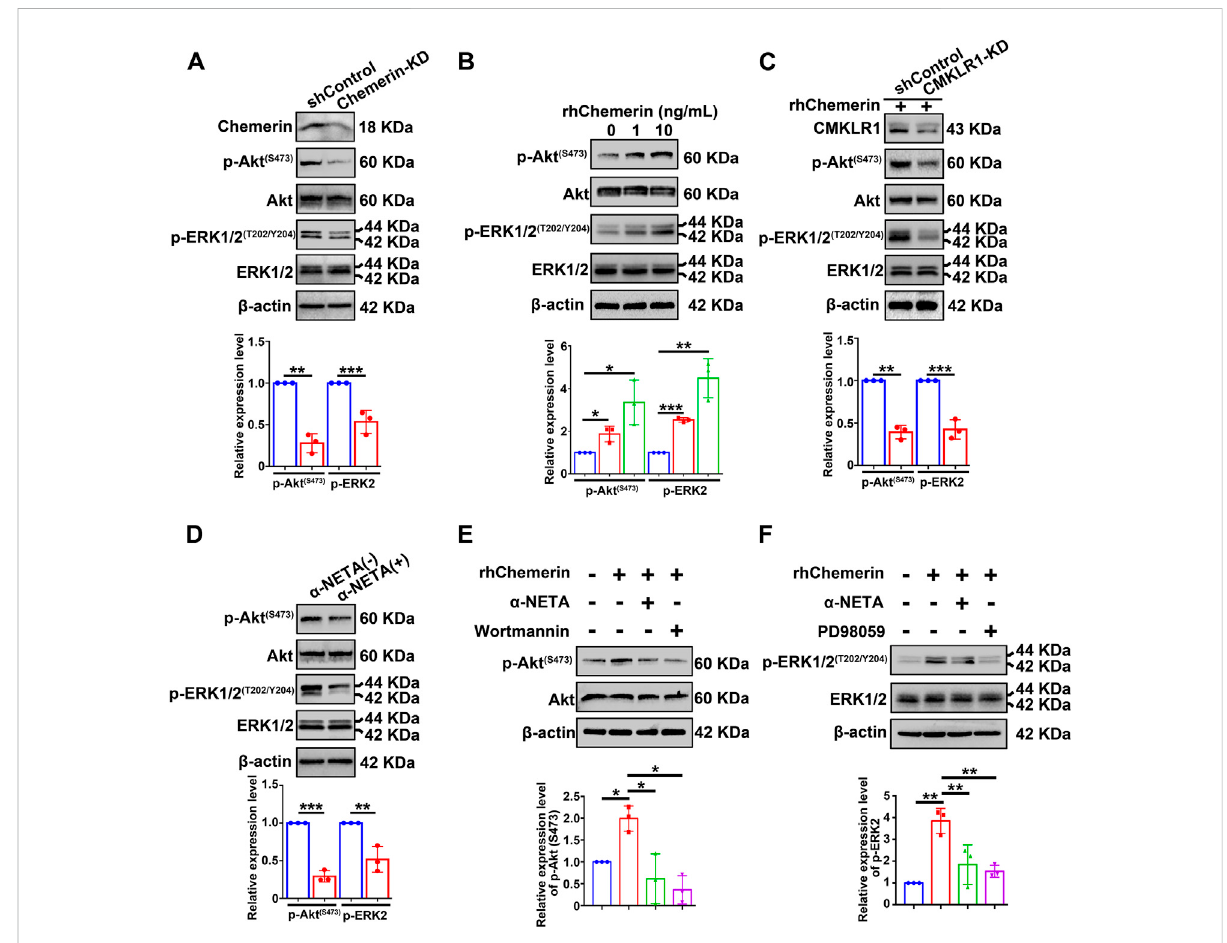
FIGURE 5 ChemerinactsonCMKLR1toactivatethePI3K/AktandMAPK/ERKsignalingpathwaysinhEM15Acells. (A) Immunoblotsofchemerin,p-Akt (S473) , Akt, p-ERK1/2 (T202/Y204) , ERK1/2 in shControl and chemerin-KD cells. (B) Immunoblots of p-Akt (S473) , Akt, p-ERK1/2 (T202/Y204) , ERK1/2 in hEM15A cells treated with rh-chemerin for 5 min. (C) Immunoblots of CMKLR1, p-Akt (S473) , Akt, p-ERK1/2 (T202/Y204) , ERK1/2 in shControl and CMKLR1-KD